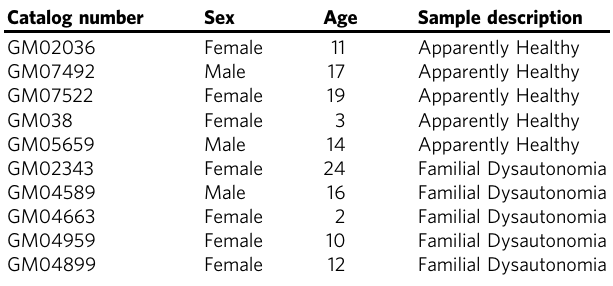
Table 2 Human fi broblast lines.